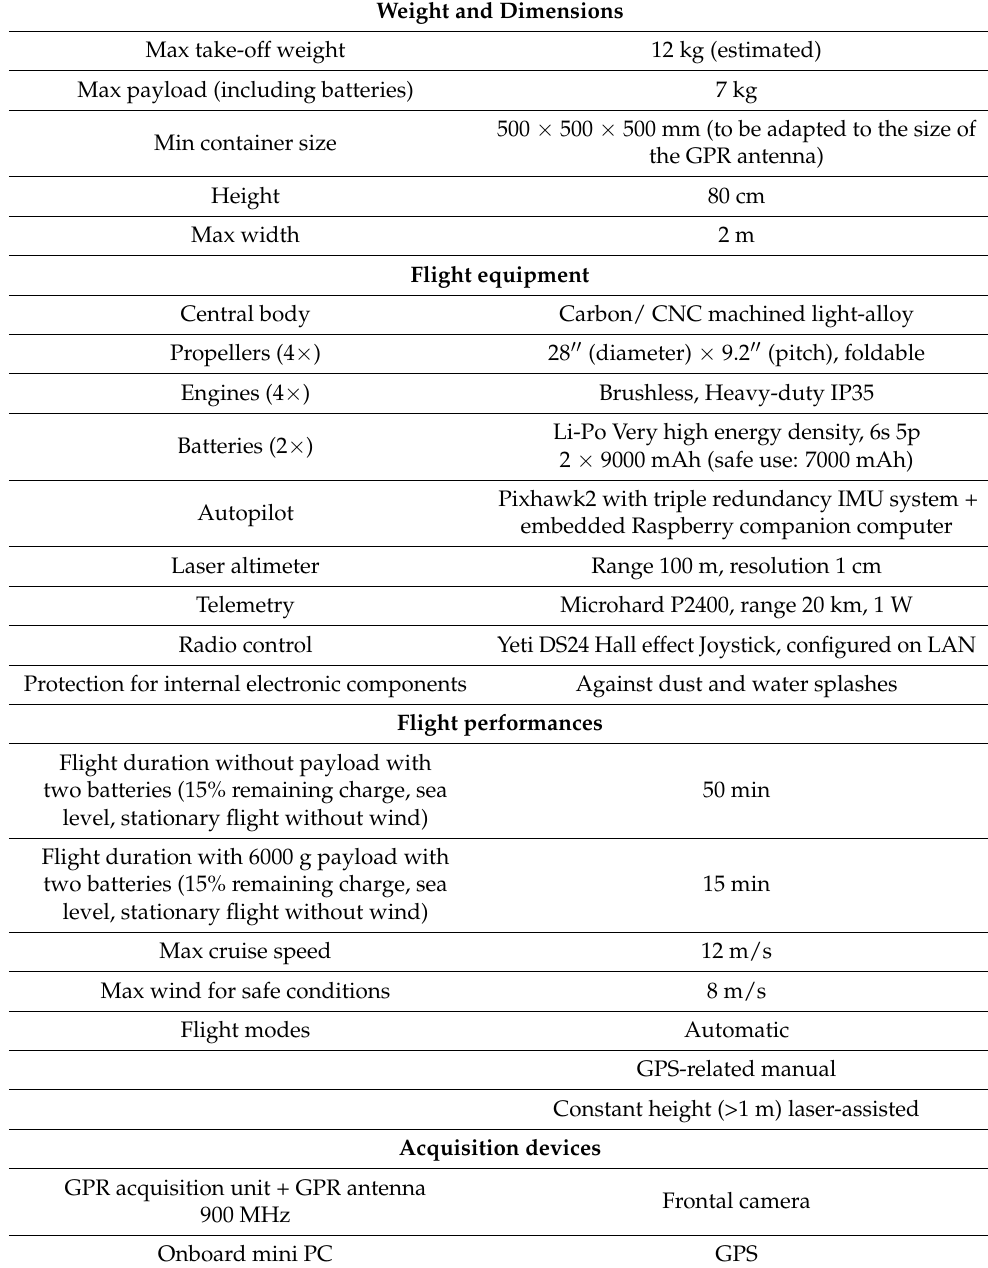
Table 1. Main features of the drone Venture VFF_H01 prototype. Weight and